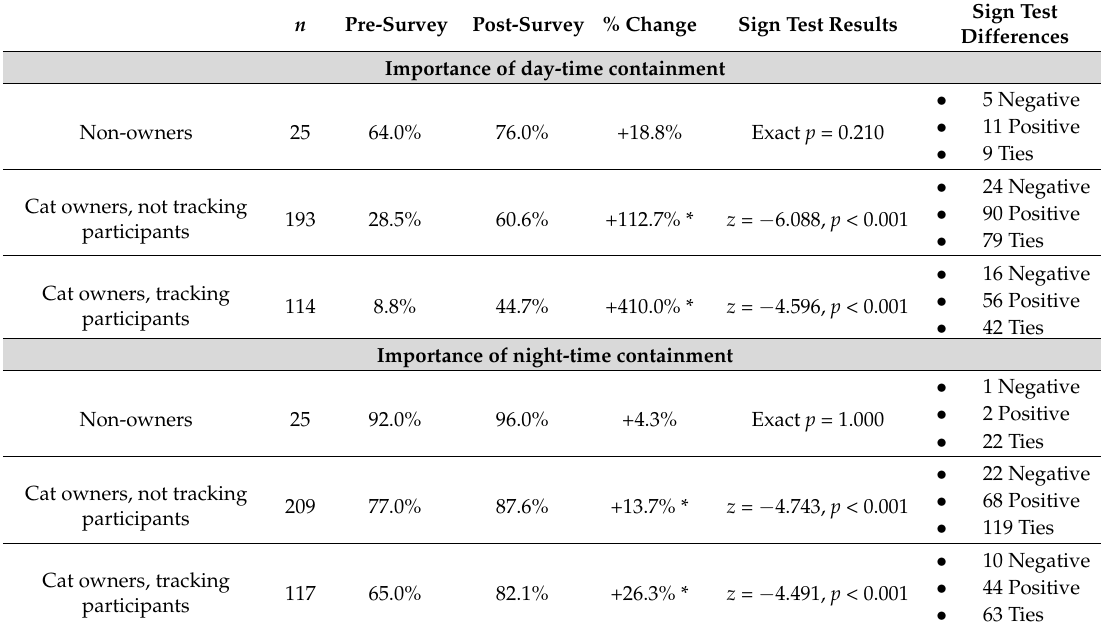
Table 3. Changes in attitude towards the containment of pet cats. Percentages for the pre-test and post-surveys are the percentages of respondents who indicated that containment was important or very important on a five-point scale (very unimportant to very important) in response to the statement “Please indicate how important you think it is to contain a cat (e.g., keep the cat inside a house or cat run)?” Sign tests we used to determine if the changes were statistically significant (significant results are marked with an